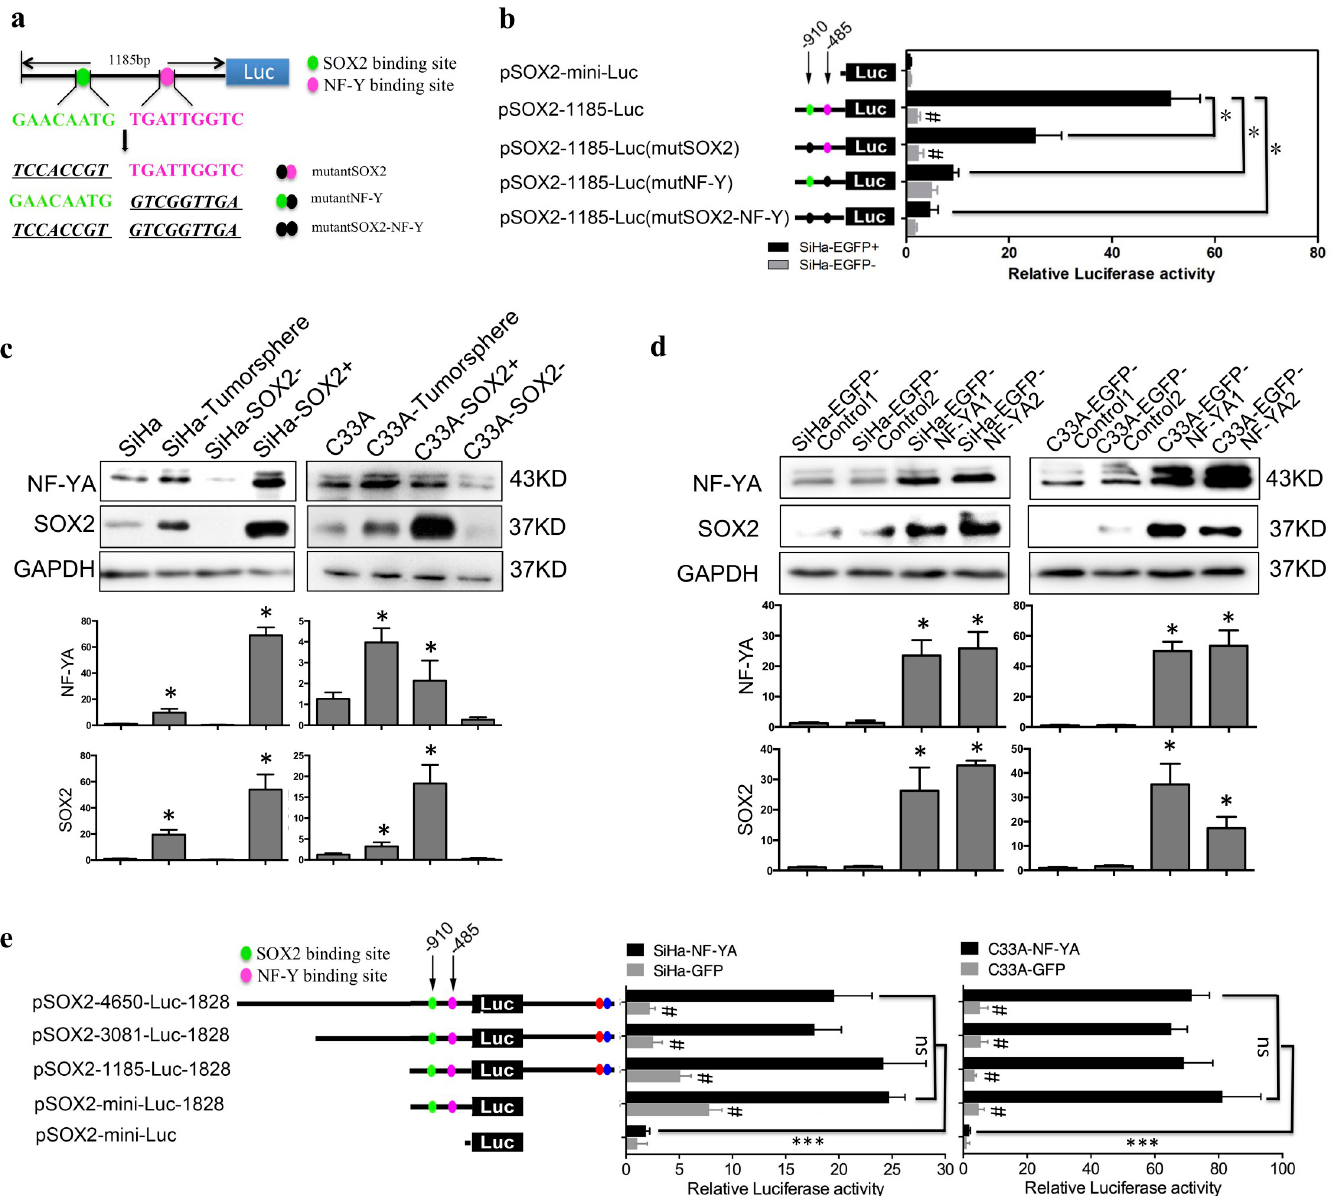
Fig 4. The NF-YA binding site CCAAT/ATTGG box was required for the transcription of SOX2 in cervical CSCs. (a) The mutations of SOX2 and NF-Y binding sites upstream of the SOX2 promoter 5’UTR. (b) The luciferase activity of the SOX2 promoter mutations (green dot: SOX2 binding site; pink dot: NF-Y binding site; black dot: mutant of SOX2 or NF-Y binding site). (c) NF-YA protein expression was detected in SiHa and C33A cells cultured in adherent culture and tumorsphere, as well as SOX2+ and SOX- SiHa and C33A cells and densitometric analysis was performed related to GAPDH. (d) NF-YA was overexpressed in SiHa and C33A cells and the expression levels and densitometric analysis of NF-YA and SOX2 were detected by Western blot. (e) The luciferase activity of the SOX2 promoter deletions in NF-YA-overexpressing SiHa and C33A cells. Data is presented as the mean ± SD of experiments in triplicate and statistically analyzed using student’s t -test. The symbols represent the following: � , p < 0.05; ��� , p < 0.001; #, NF-YA group vs GFP group and p < 0.05; ns = no statistical difference.